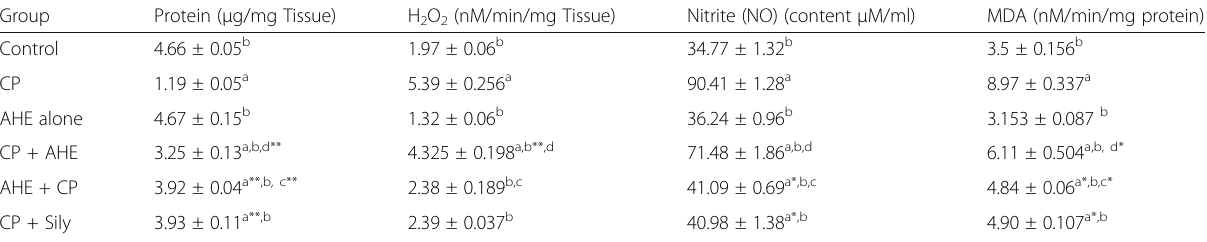
Table 5 Effect of cisplatin (CP) and different treatments of AHE on liver tissue protein, H 2 O 2 , nitrite content and lipid peroxidation Group Protein ( μ g/mg